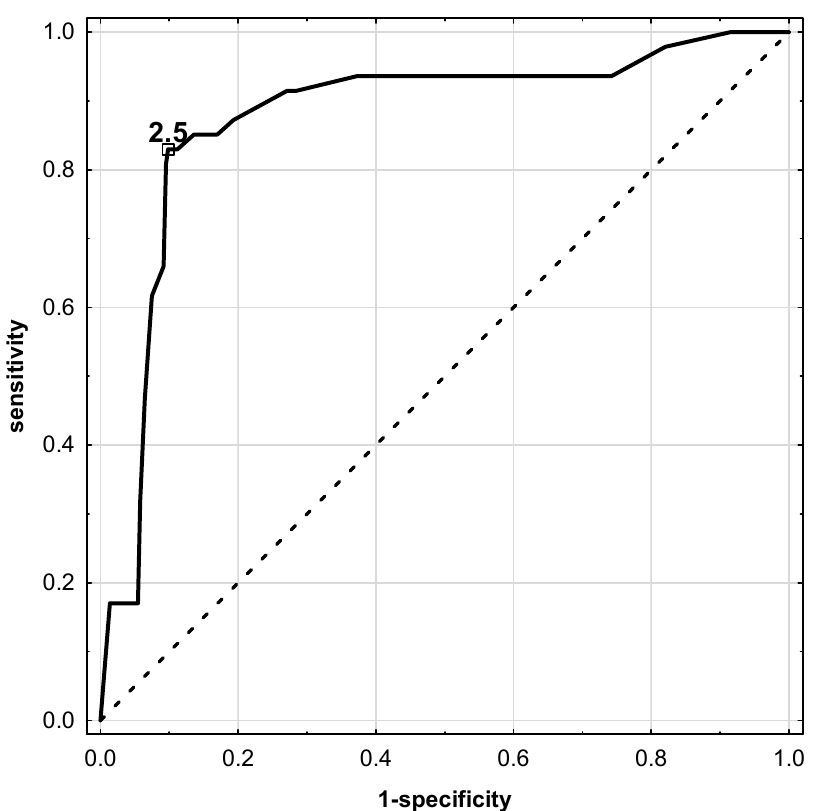
Figure 2. ROC analysis for TSH concentration in serum of patients before surgical treatment. Solid line—TSH parameter. Analysis showed cut-off point for prediction of thyroid cancer as ≥ 2.50 mU/L.